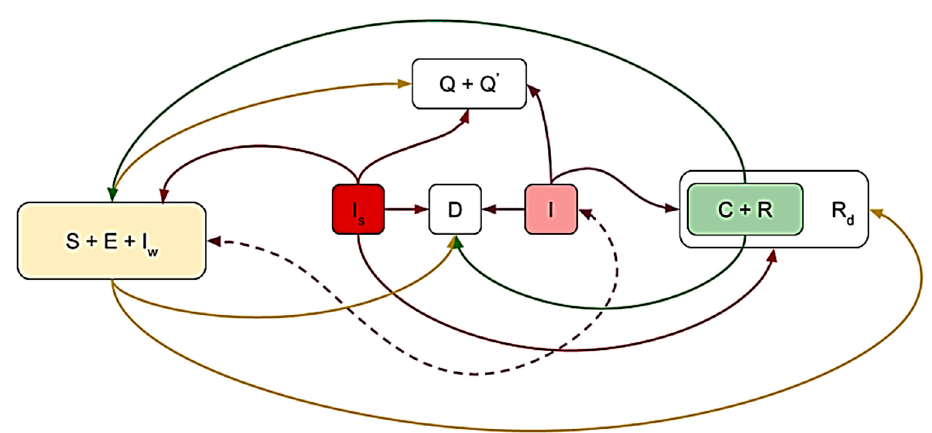
Figure 2. The basic migration principles indicated for group under the influence of which the participant is migrating by the proposed SIR model: susceptible (S), non-contagious (E), infected people who ignore the symptoms (I_s), infected (I), asymptomatic infected (I w ), in quarantine (Q), in the intensive care unit (Q’), carriers (C), recovered (R), recovered immobilized (R d ), deaths (D).